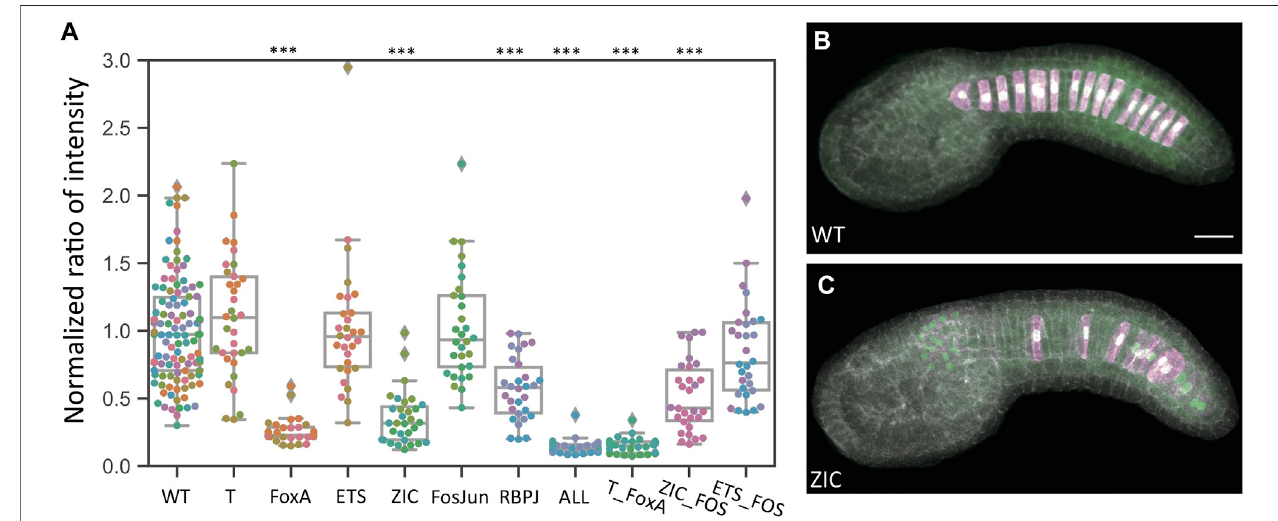
FIGURE 2 | Quantitative effects of TFBS mutations in the bra proximal enhancer. (A) Comparison of normalized dual reporter intensity ratios for the wildtype and mutant bra reporter constructs. Each datapoint represents adifferent imaged embryo. Each colorindicates embryos from the same replicate.The box plotsindicate the outlier-adjusted minimum, 1st quartile, median, 3rd quartile and outlier-adjusted maximum for each construct. Outliers are marked as lozenges. Asterisks indicate differential reporter expression between the TFBS mutation construct and the wildtype construct. *** p < 0.001. (B – C) Representative sum-projected confocal images. (B) , wild type reporter construct. (C) , ZIC mutant reporter construct. Magenta: YFP reporter expression. Green: Bra > H2B:HA internal control expression. Gray, phalloidin. Scale bar, 20 µm.